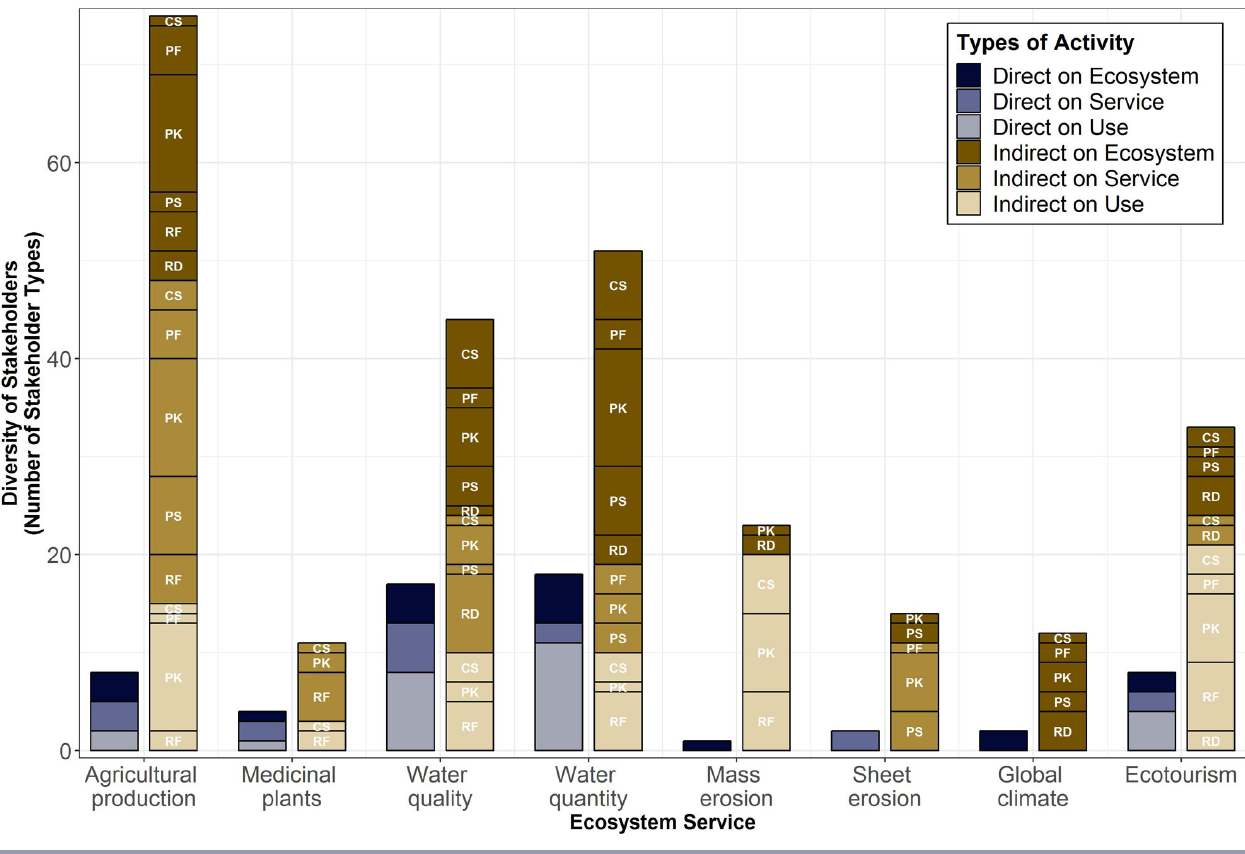
Fig. 3 . Diversity of stakeholders, i.e., number of different stakeholder types, at each step of the cascade and for the two different modalities of management: direct and indirect. Different options of indirect management are distinguished: coordinate and supervise actors (CS), provide finance (PF), provide knowledge and skills (PK), provide supplies and materials (PS), regulate ecosystem service flows (RF), and restrict ecosystem service degradation